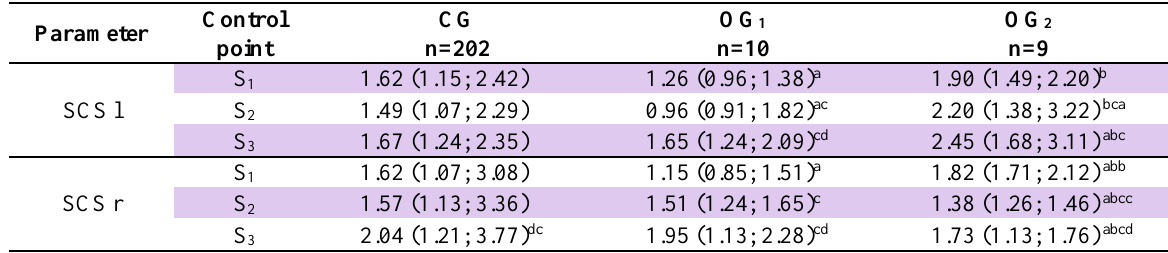
Table 2. Differences in switching rates of switching of central settings in highly skilled athletes under the influence of intense training load and in the period of early recovery